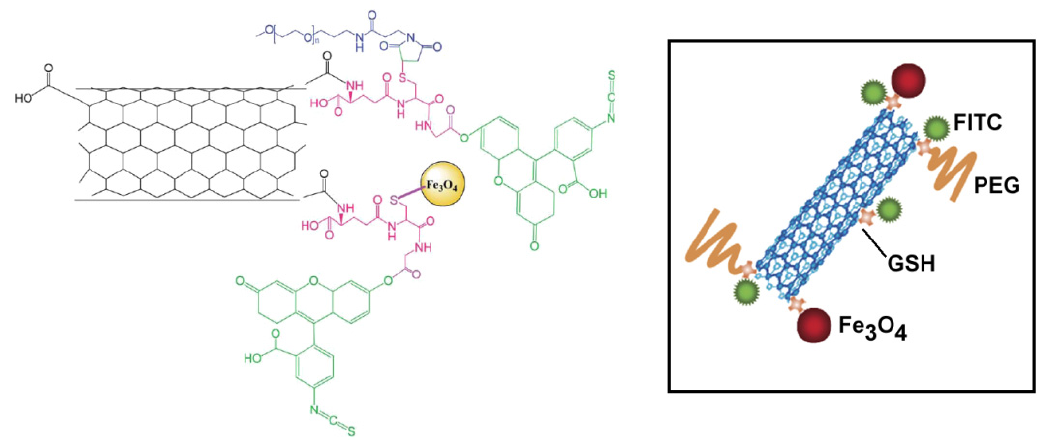
Figure 15. Chemical formula of the Fe illustration of multicomponent Fe (GSH) ( right